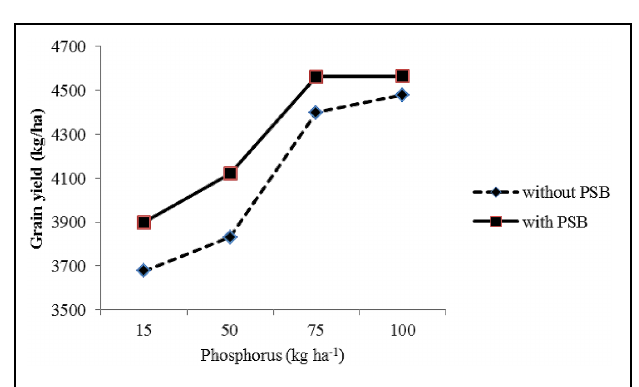
FIGURE 3 | Response of number of grains per row of maize ( Zea mays L.) to compost application time (C) and phosphate solubilizing bacteria (PSB) interaction (C × PSB).